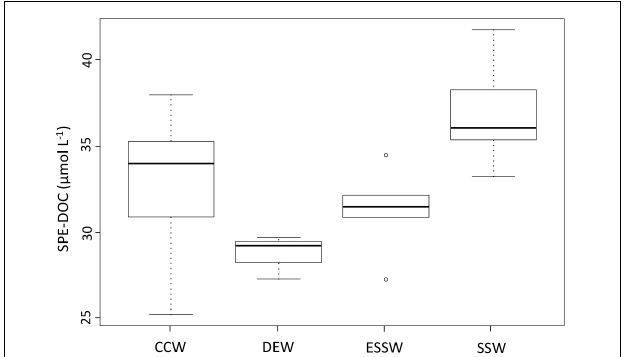
FIGURE 5 | Solid-phase extractable dissolved organic carbon (SPE-DOC) variability between the water masses off central Peru during 2015. CCW: Coastal Cold Waters ( n = 22), DEW: Deep Equatorial Waters ( n = 4), ESSW: Equatorial Subsurface Waters ( n = 6), SSW: Surface Subtropical Waters ( n =